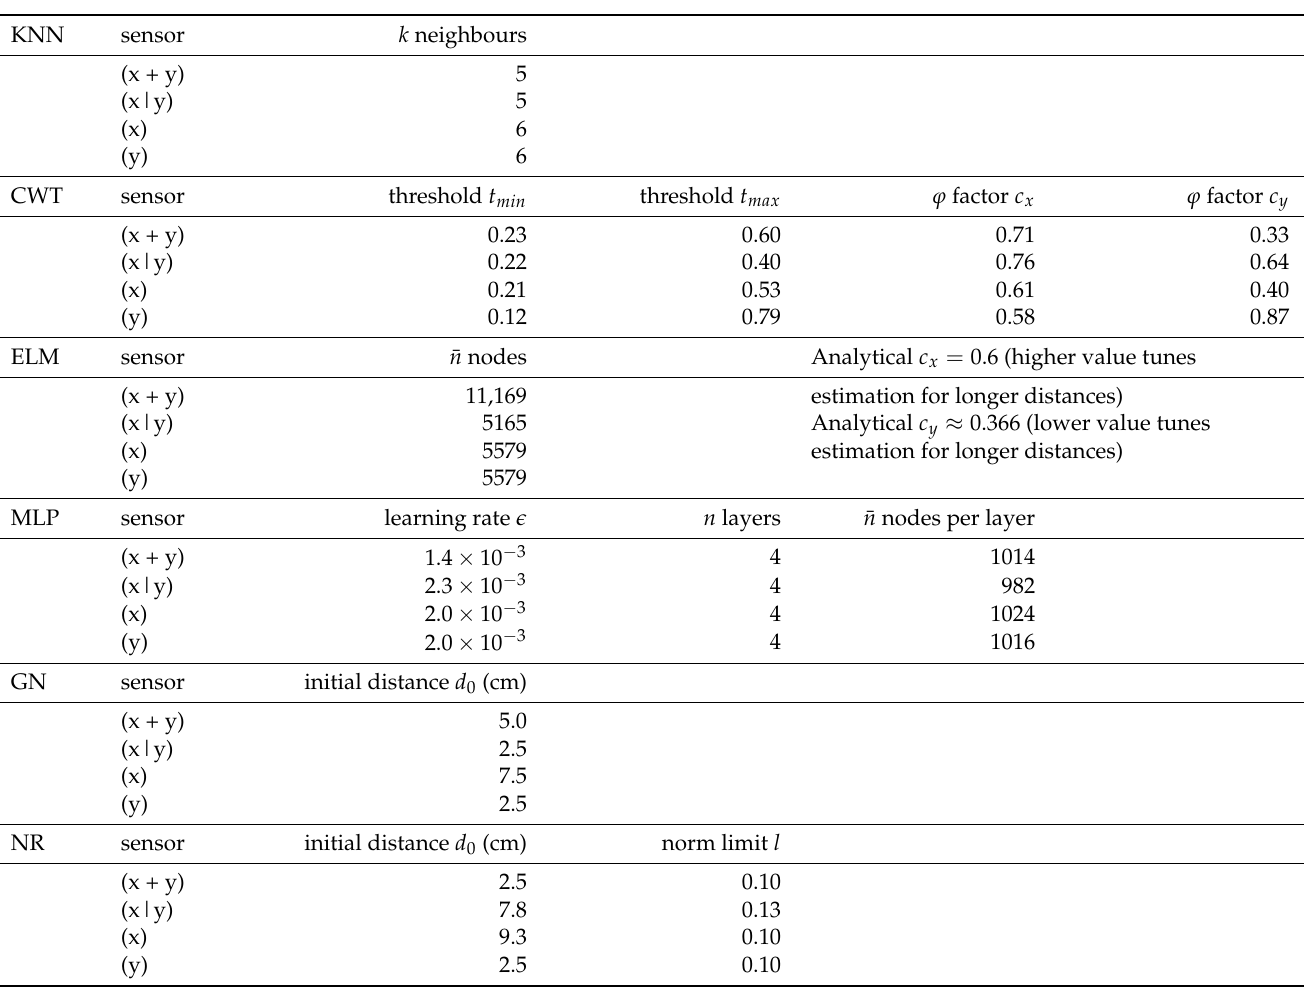
Table A2. All hyperparameters for the second analysis optimised using the training set. This analysis varied the sensor sensitivity axes to show how the velocity components contribute to the predictions while keeping D s constant. The config- urations were: (x + y) both components on all sensors, (x|y) alternating v x and v y for subsequent sensors, (x) only v x on all sensors, (y) only v y on all sensors. The σ = 1.0 × 10 − 5 ms − 1 noise level was used and with the D s = 0.01 training and optimisation